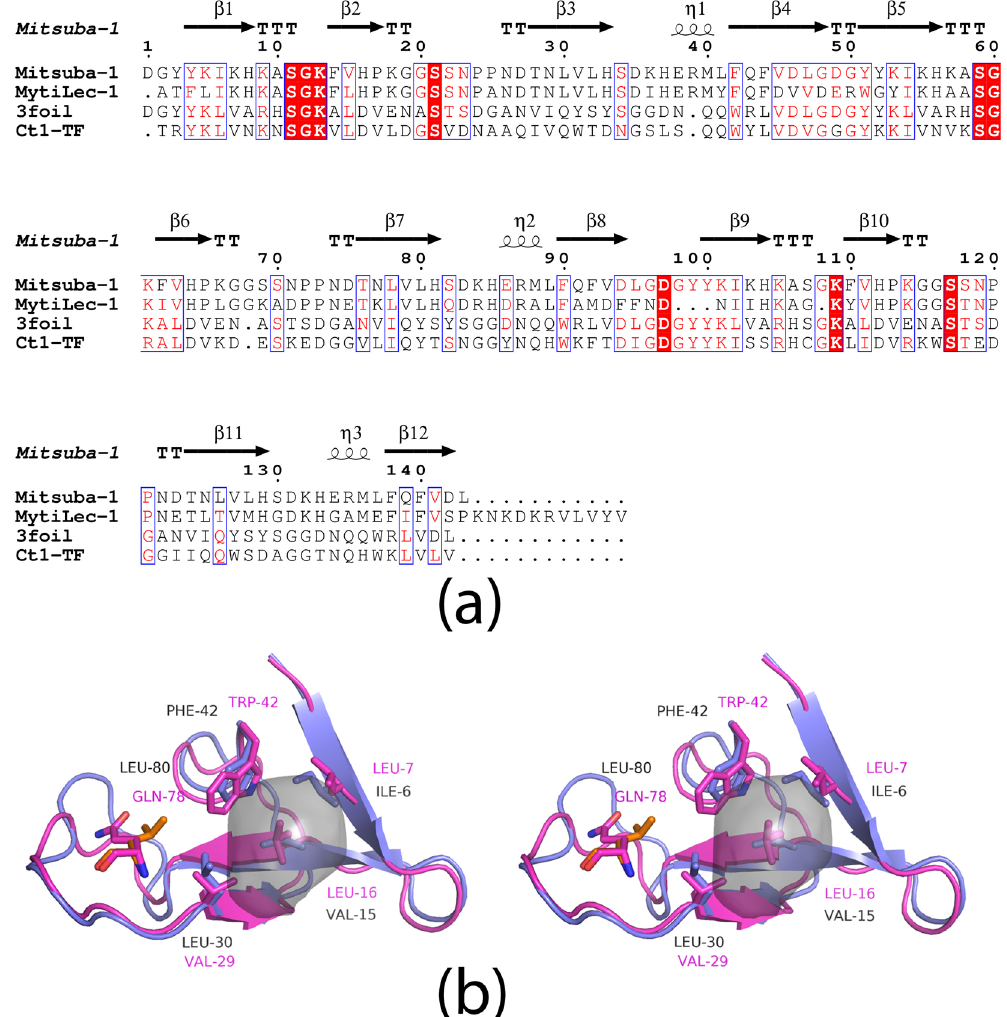
Figure 4. Comparison of Mitsuba with Threefoil. ( a ) Sequence alignment of Mitsuba-1 with related β -trefoils. The secondary structure elements of Mitsuba-1 (detected automatically) are shown as arrows and coils. The PDB entries for Threefoil and Ct1 are 3PG0 and 3VSF respectively. The N-terminal catalytic domain of Ct1 is omitted. Mitsuba-1 shows 29% sequence identity to Threefoil, and only 22% to Ct1. Threefoil shows 48% sequence identity with the Ct1 trefoil domain. The figure was drawn using ESPRIPT 58 . ( b ) A stereo ribbon diagram of the first subdomain of Mitsuba-1, shown in purple. The central cavity of the protein is shown as a translucent grey surface. Threefoil (shown in pink) has several mutations compared to Mitsuba-1 in the central region, and the notable mutations are shown as sticks and labelled. Threefoil has Trp 42 (and two equivalents in the other subdomains) in place of Phe 42 of Mitsuba-1. This larger side-chain is accommodated by Gln 78 and the altered backbone structure nearby, but Leu 80 of Mitsuba-1 would clash with the tryptophan. The hydrophobic core of Threefoil is also filled by Leu 16; replacements at positions 7 and 29 on either side of this side-chain allow better packing, leaving no significant cavity. Cavity analysis was performed with KVFinder 25